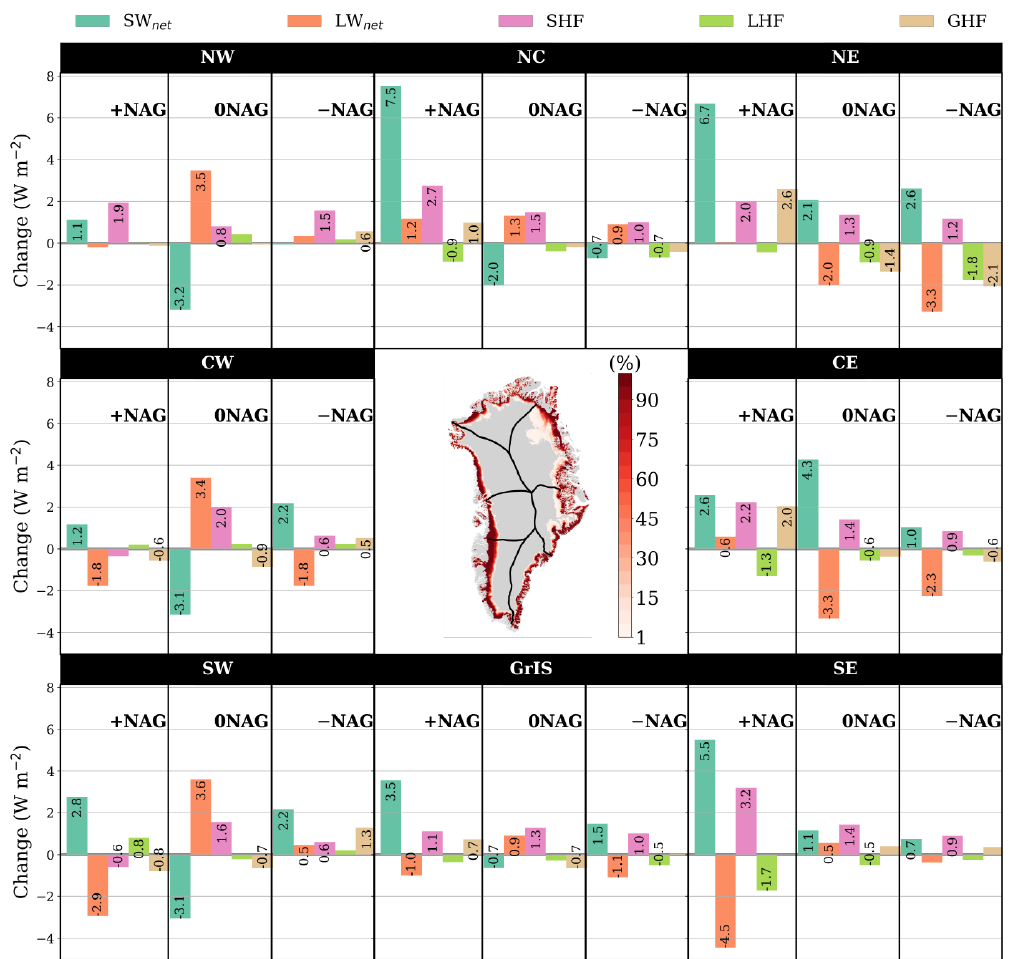
Figure 6. Composite change on surface energy fluxes in the summer ablation zone for each NAG phase between 1959–1990 and 1991–2020. The regional contribution for seasonal averages is shown at the center as relative frequencies. The significance for the mean difference is shown in Fig. S14, and the absolute SEB fluxes for each period are shown in Fig.